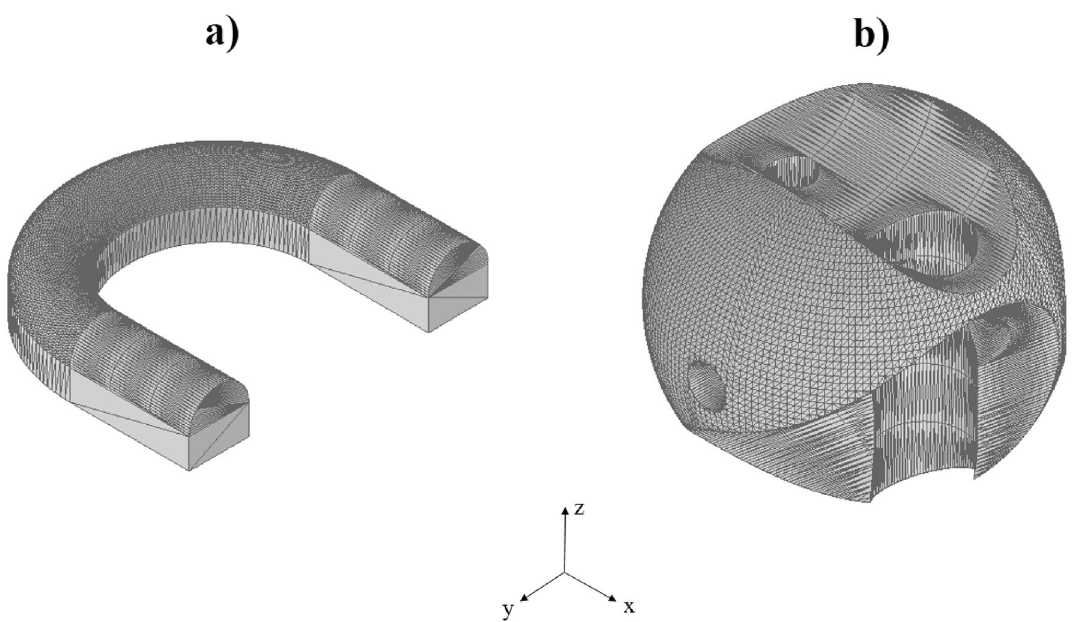
Figure 8. Non-convex shapes ( a ) U-shape and ( b ) special sphere.